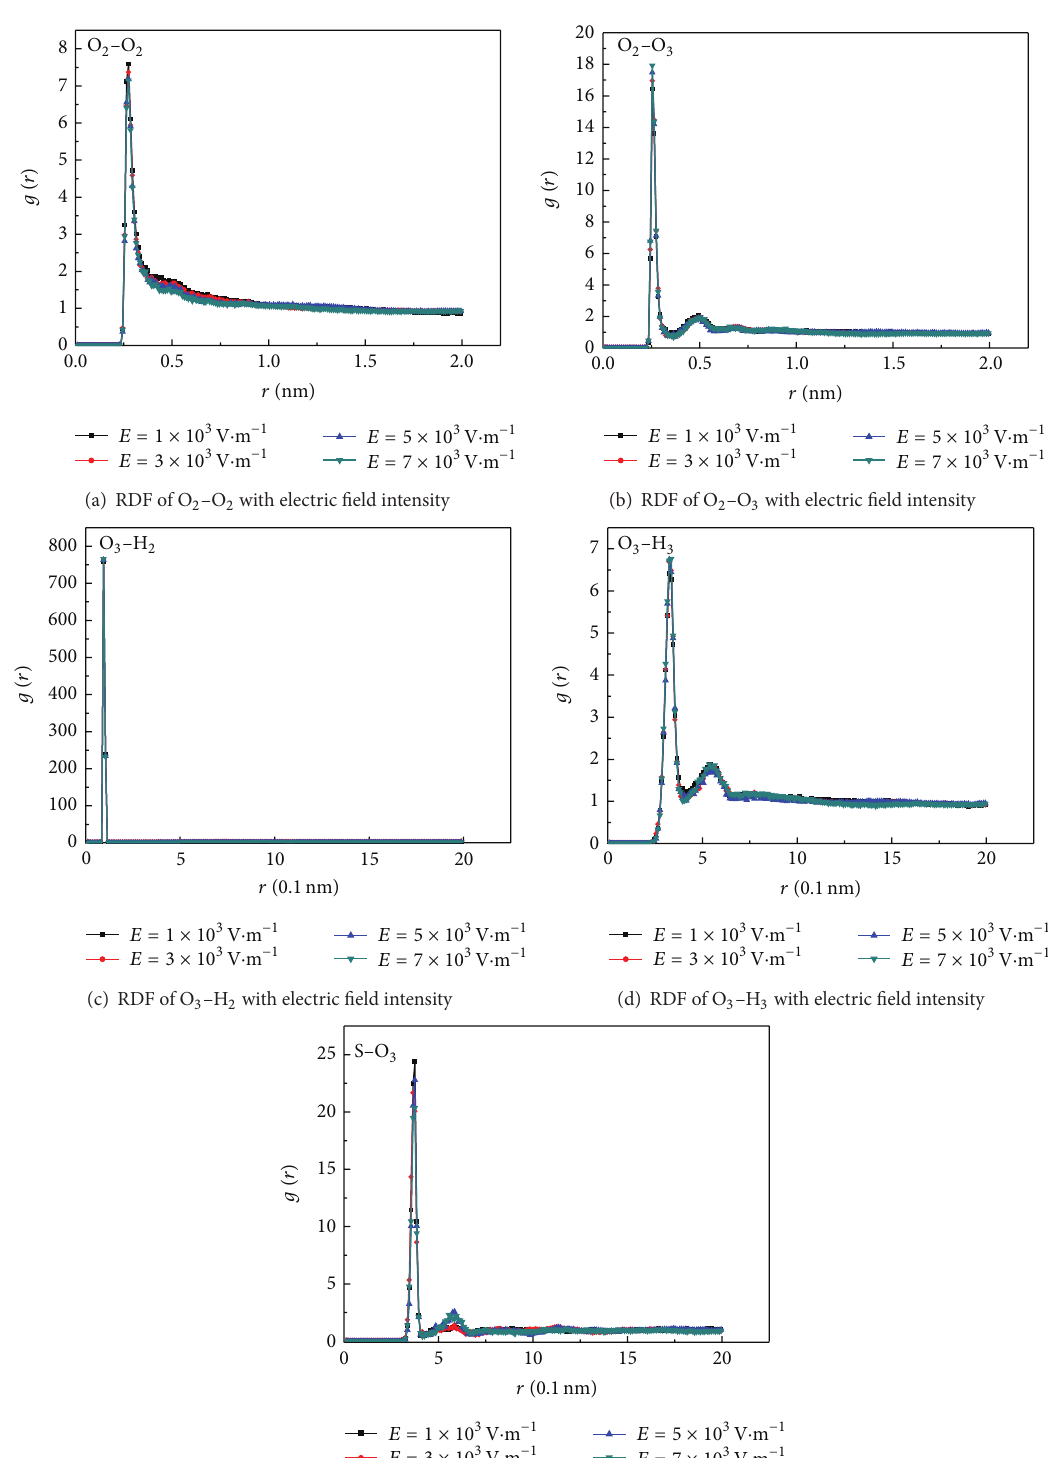
Figure 10: The RDFs of different pairs of particles at different electric field intensities with 𝑇 = 333 K and 𝜆 = 8